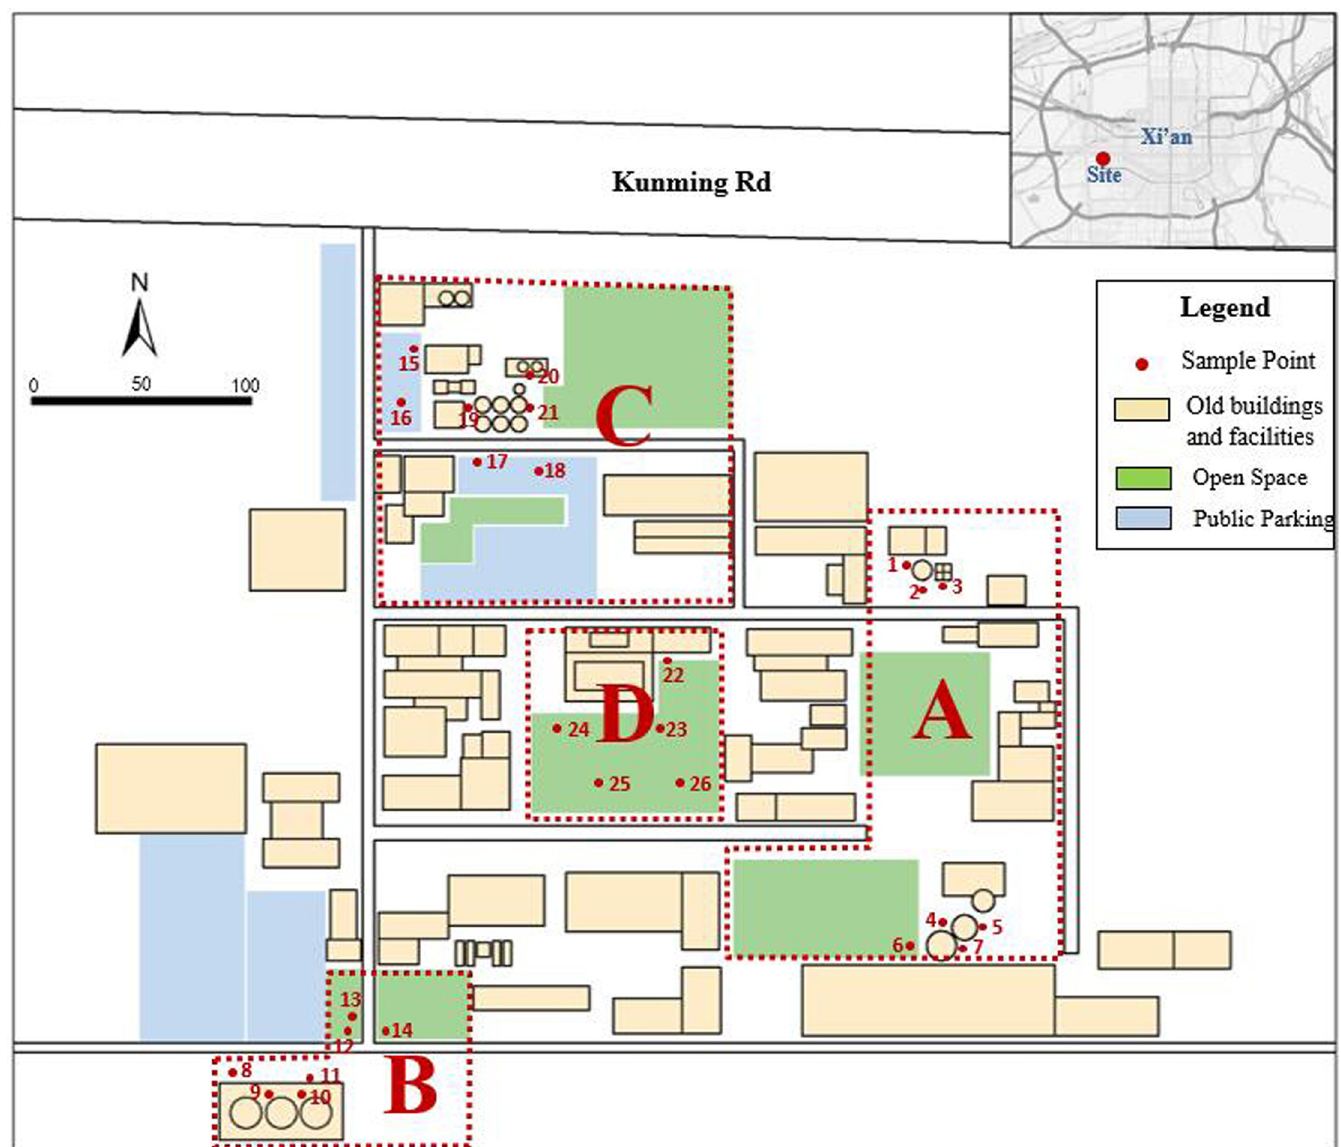
Fig 1. Study area and soil sample points.